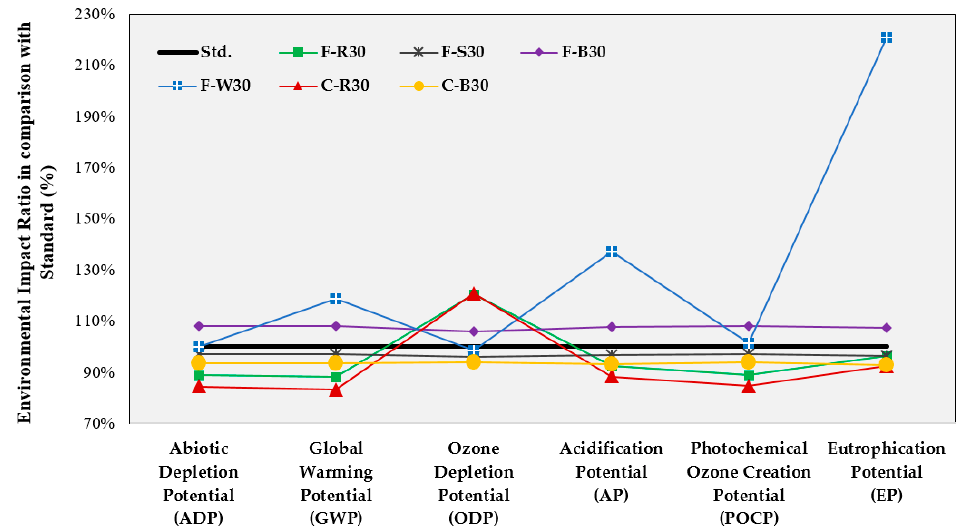
Figure 2. Figure 2. Environmental Impact Ratio of Each Evaluation Target in Comparison with the Standard Mixture. Table 7. Results of the Evaluation of the Six Environmental Impacts of the Evaluation Targets.